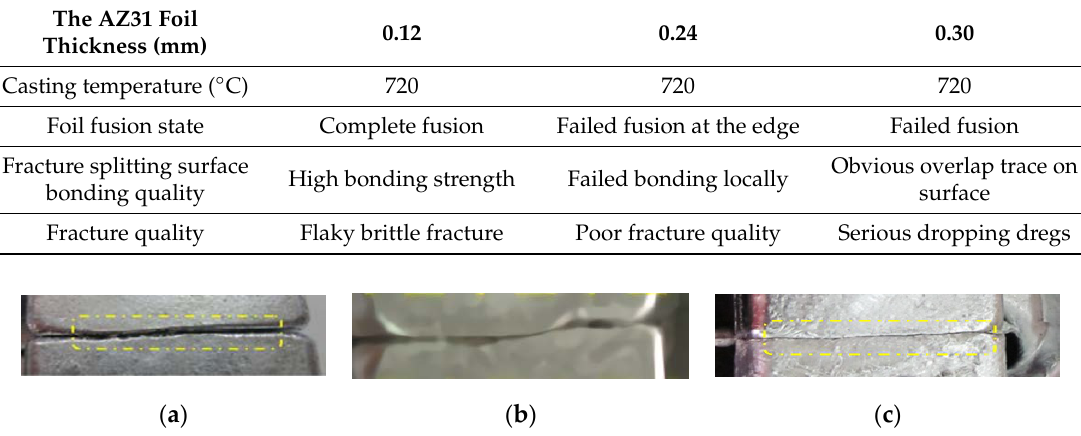
Table 3. Fracture splitting surface quality with AZ31 foils of di ff erent thicknesses.